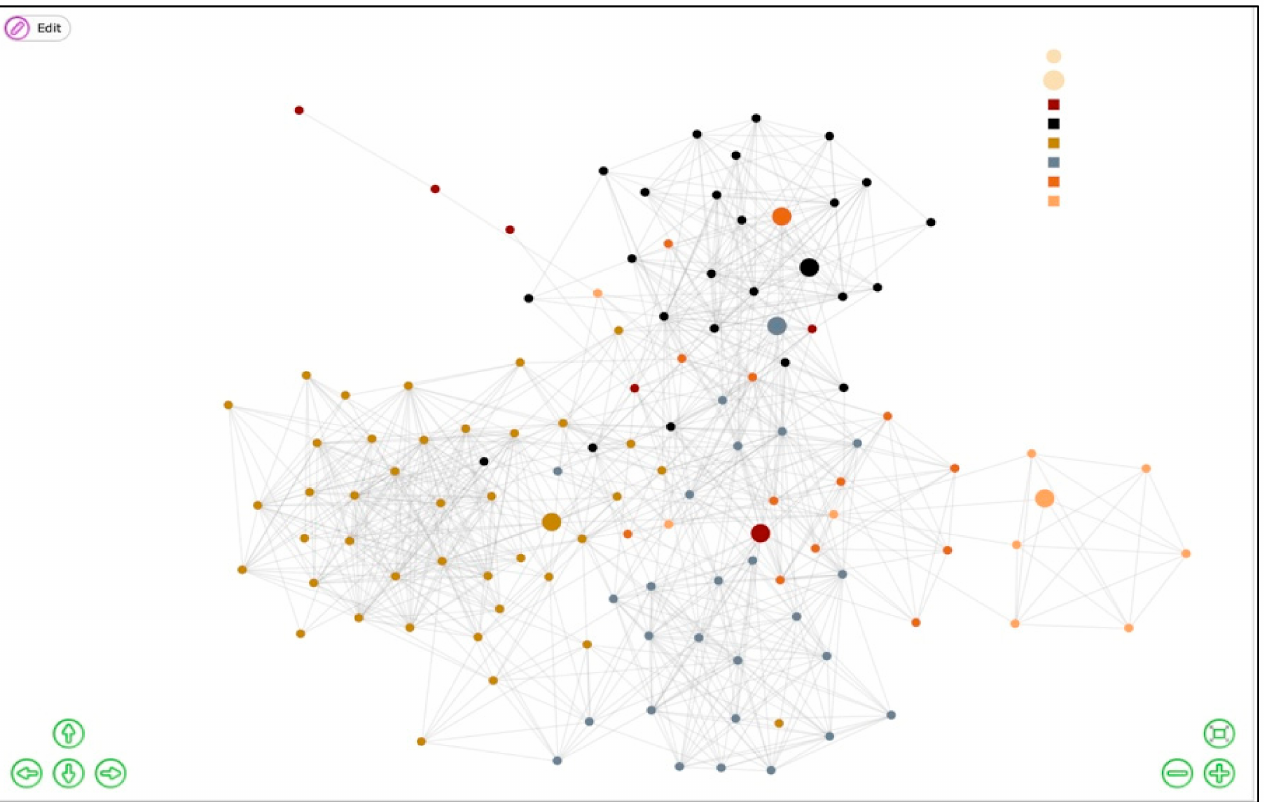
Figure 21. Authors’ interactive co-collaboration